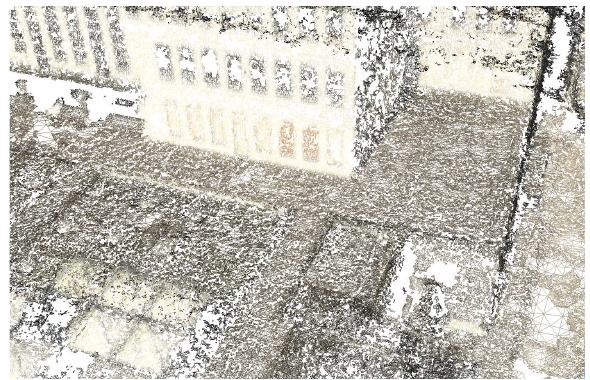
Figure 7: Mesh patches generated from oblique airborne imagery. RQT error threshold ǫ = 2 .